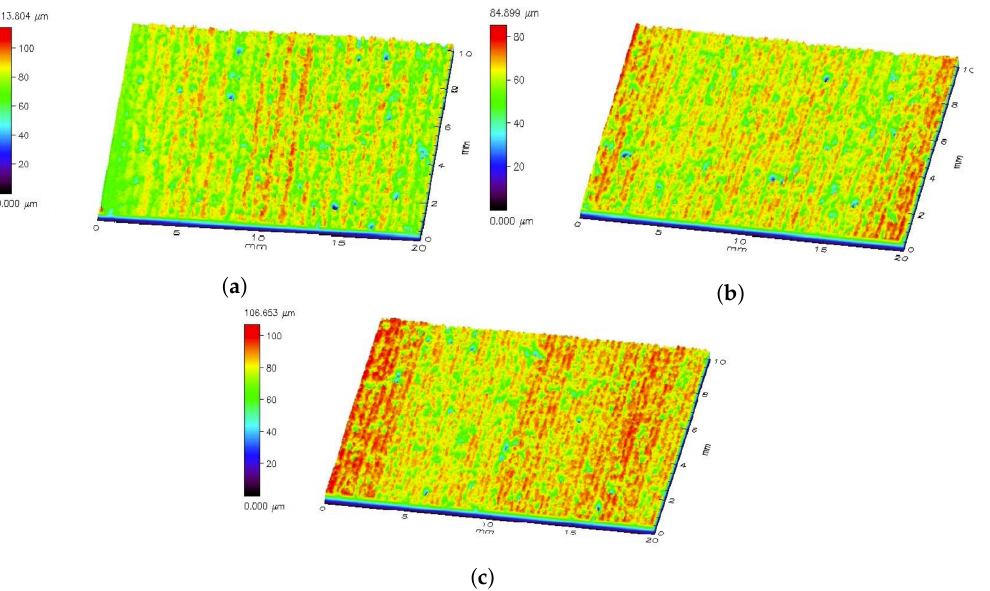
Figure 9. The 3D surface topography of marble test samples cut with the bandsaw using ( a ) sealed bearings as both the upper and the lower guides; ( b ) hydrostatic upper guides and lower bearing guides; ( c ) hydrostatic upper guide and no lower guide.